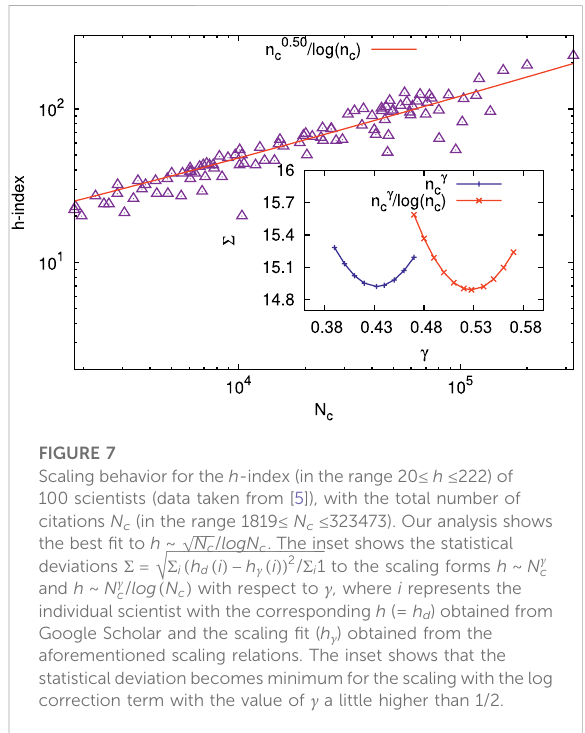
FIGURE 7 Scaling behavior for the h -index (in the range 20 ≤ h ≤ 222) of 100 scientists (data taken from [5]), with the total number of citations N c (in the range 1819 ≤ N c ≤ 323473). Our analysis shows (cid:1)(cid:1)(cid:1) √ (cid:1)(cid:1)(cid:1)(cid:1)(cid:1)(cid:1)(cid:1)(cid:1)(cid:1)(cid:1)(cid:1)(cid:1)(cid:1)(cid:1)(cid:1)(cid:1)(cid:1)(cid:1)(cid:1) (cid:4) the best fi t to h ~ N c / logN c . The inset shows the statistical Σ ( h ( i ) − h γ ( i )) 2 / Σ deviations Σ (cid:3) to the scaling forms h ~ N γ c i d i 1 and h ~ N γ c / log ( N c ) with respect to γ , where i represents the individual scientist with the corresponding h (= h d ) obtained from Google Scholar and the scaling fi t ( h γ ) obtained from the aforementioned scaling relations. The inset shows that the statistical deviation becomes minimum for the scaling with the log correction term with the value of γ a little higher than 1/2.